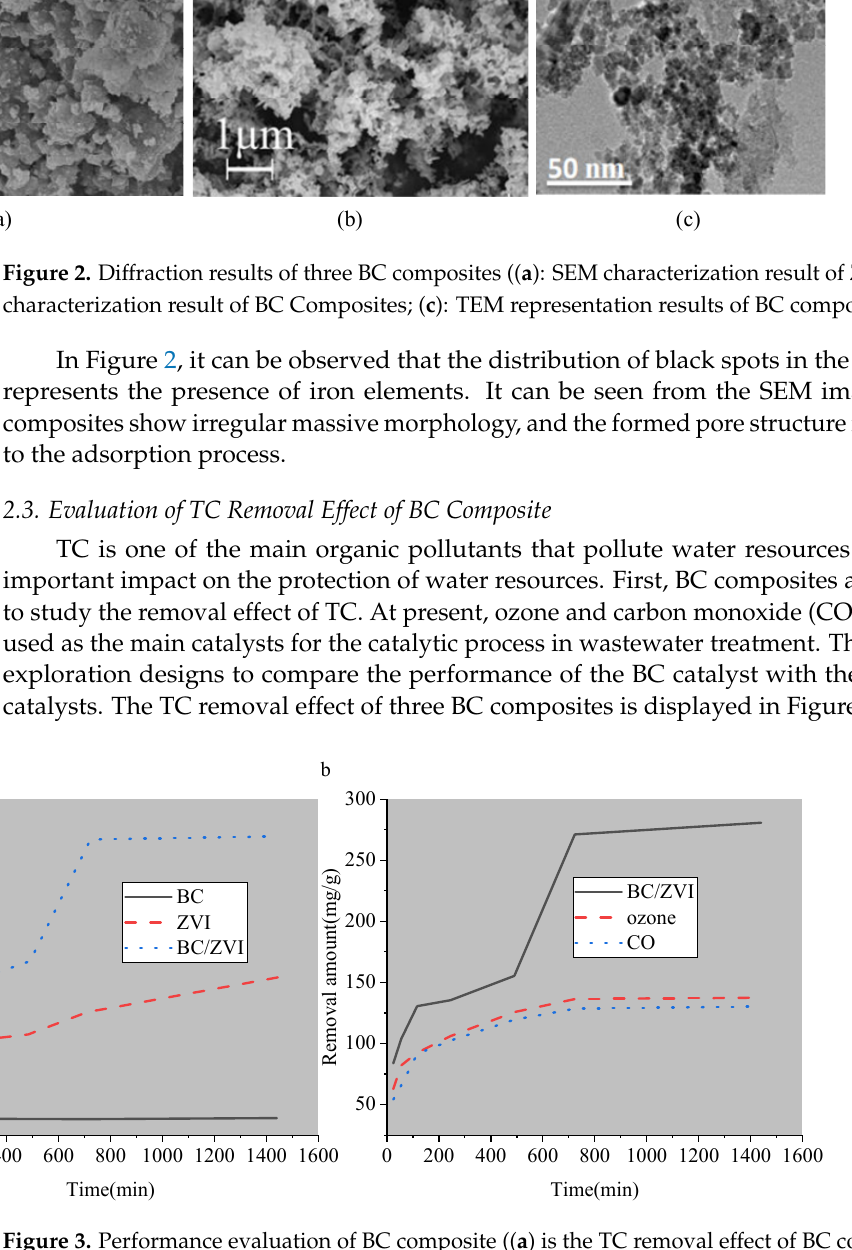
Figure 1. Diffraction results of three BC composites.